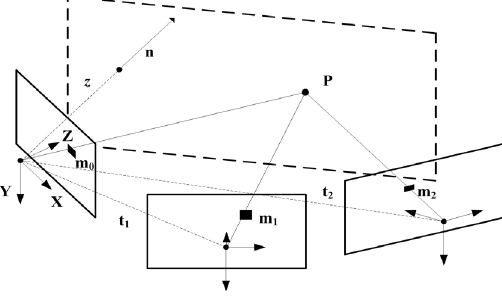
Figure 4. Scheme of the geometry of multiple views of the same plane